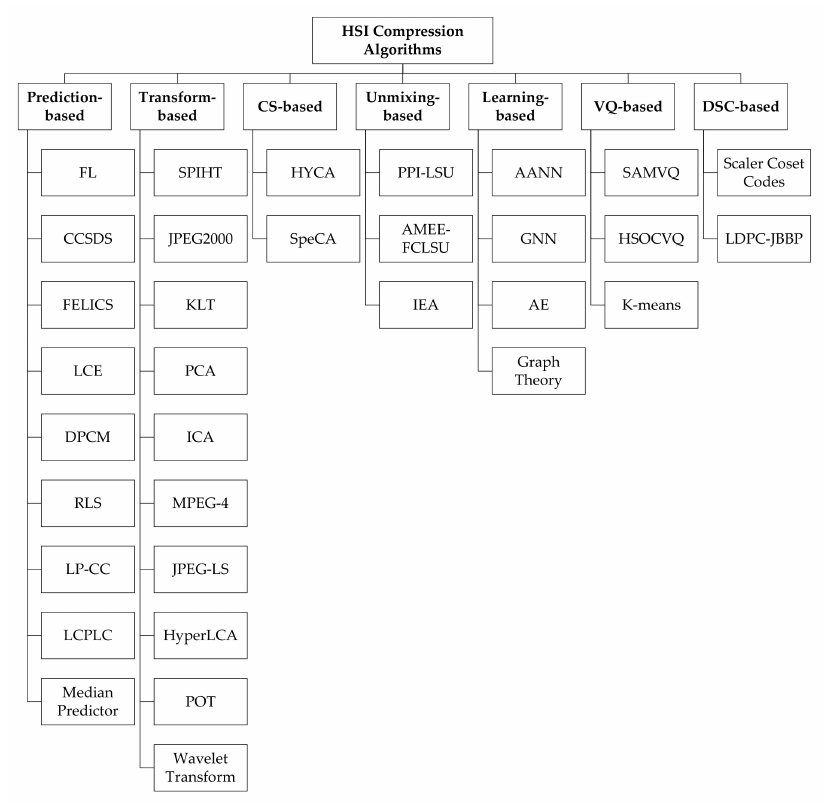
Figure 9. Taxonomy of HSI compression techniques generated by this review.